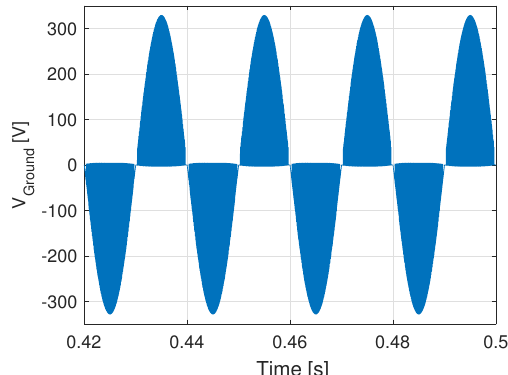
Figure 5. Basic CSI topology v ground waveform with zero C PV